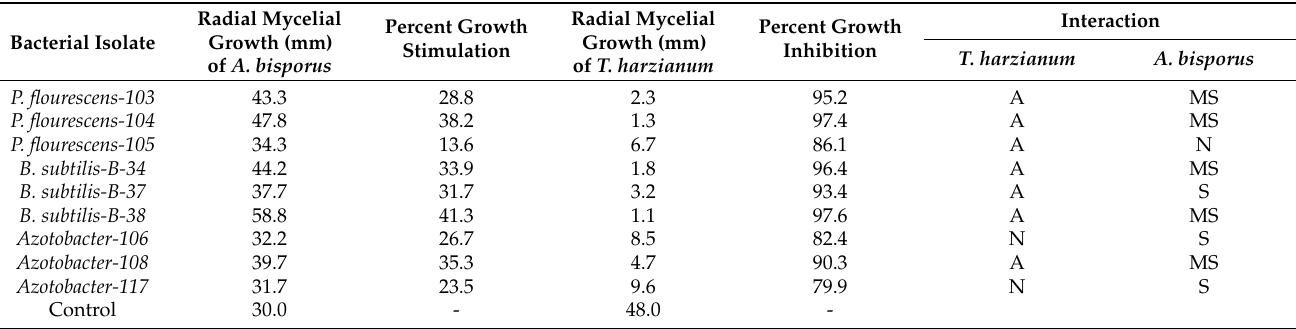
Table 6. In vitro evaluation of bacterial antagonists against mycelial growth of Agaricus bisporus and Trichoderma harzianum.